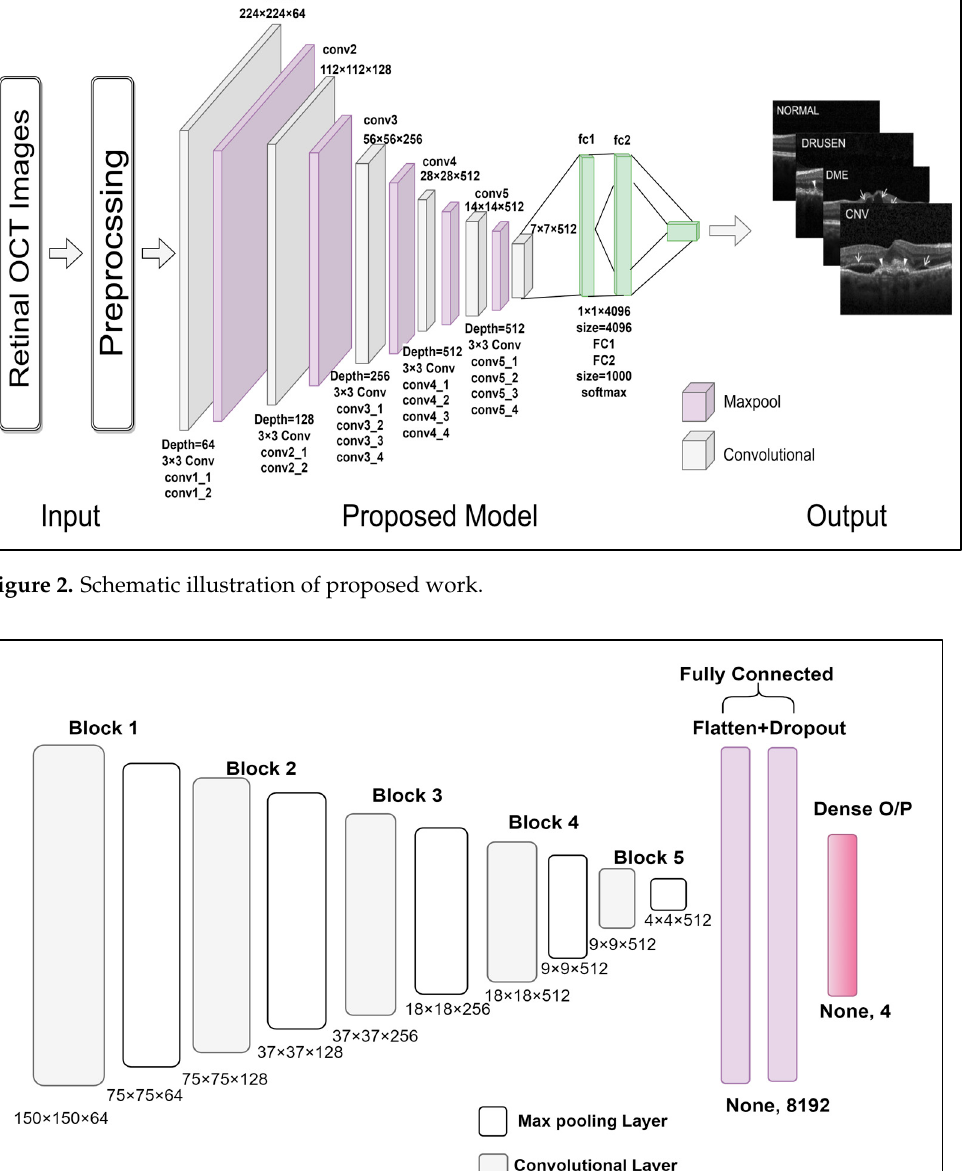
Figure 2. Schematic illustration of proposed work .